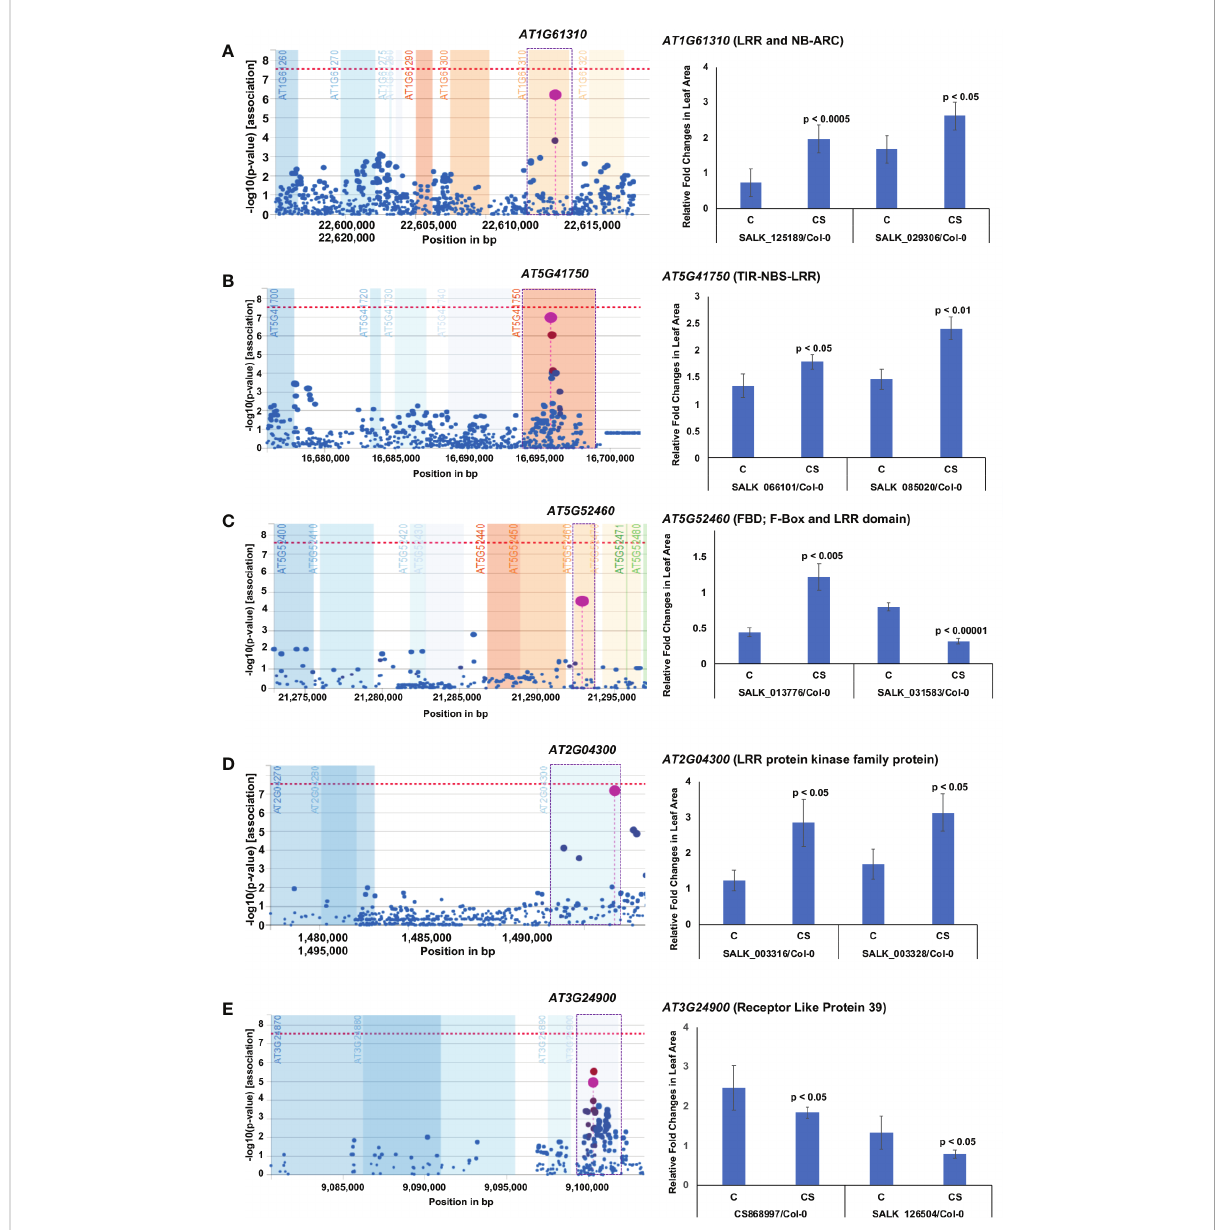
FIGURE 4 Five leucine-rich repeat domain-containing proteins contribute towards chilling tolerance. (A – E) Each of the fi ve proteins contains LRR domain. On the left, output plot of p -values ( − log base 10) in a 5-kb window for the association of SNPs with phenotypic variation, obtained from easyGWAS, is presented. On the right, rosette leaf growth rates of mutants with respect to Col-0 are presented. The relative rosette leaf growth rate in the mutant compared to wild-type Col-0 is signi fi cantly different in control (C) and cold stress (CS) ( p < Bonferroni adjusted a ) conditions. C, Comparative growth rate of the mutant relative to wild-type Col-0 in control condition; CS, Comparative growth rate of the mutant relative to wild-type Col-0 in cold